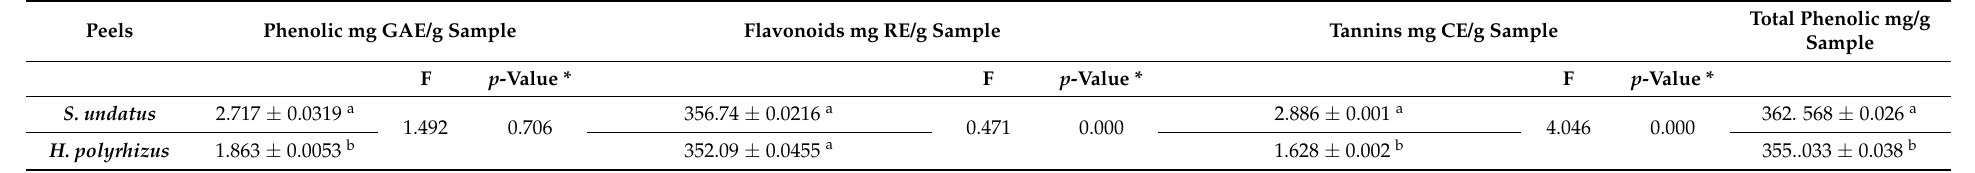
Table 1. Phenolic compounds content in methanol extracts in Selenicerus undatus and Hylocereus